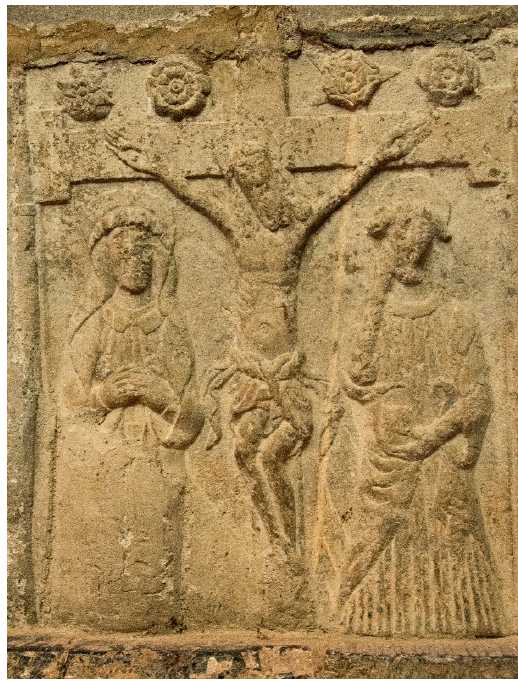
Figure 30. Slab from the tomb of James Shortall, now on the tomb of Piers and Margaret Butler, St Canice’s, Co. Kilkenny, 1507. Photograph by the author.